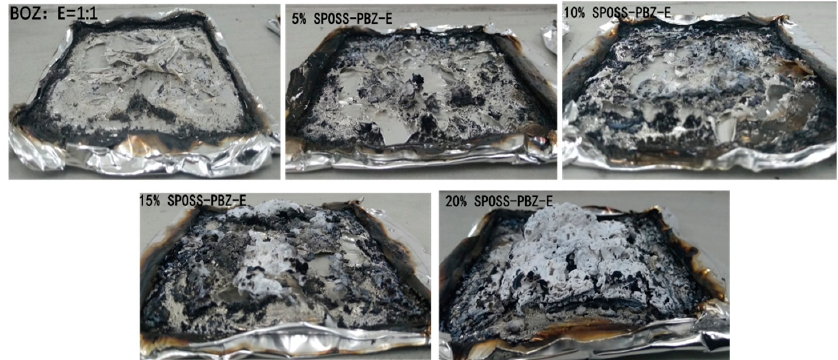
Figure 13. The char photos of nanocomposites with 0, 5, 10, 15, and 20 wt % SPOSS-BOZ after the cone calorimeter test.